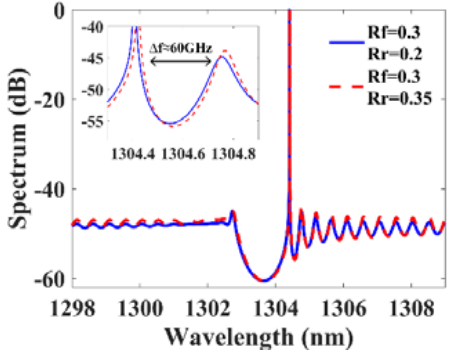
Figure 4. The lasing spectrum with L = 450 µ m and κ = 100 / cm .